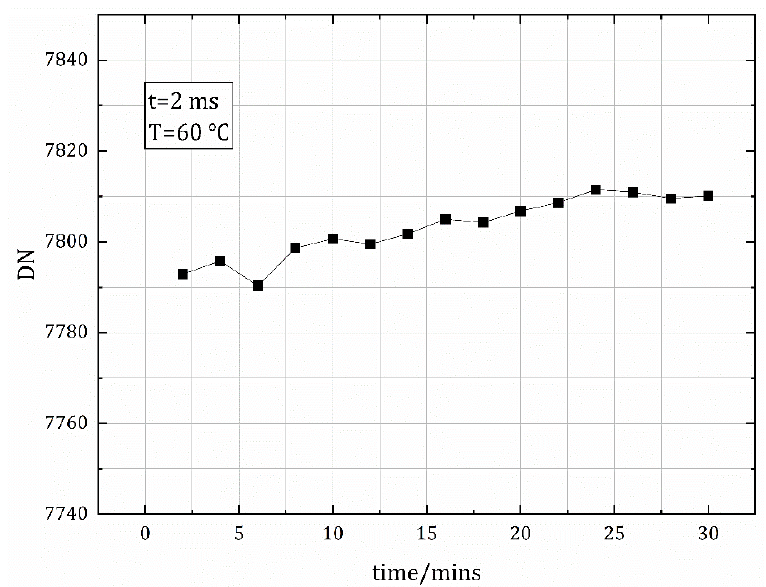
Figure 13. Image grayscale values over time when the blackbody is set to 60 °C (integration time = 2 ms).